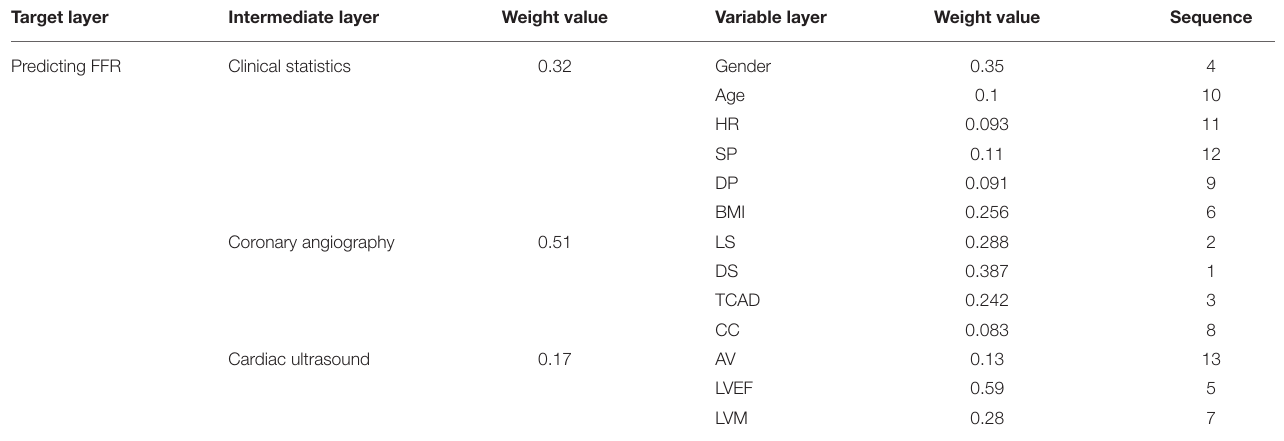
TABLE 4 | The sequence of total weight values.